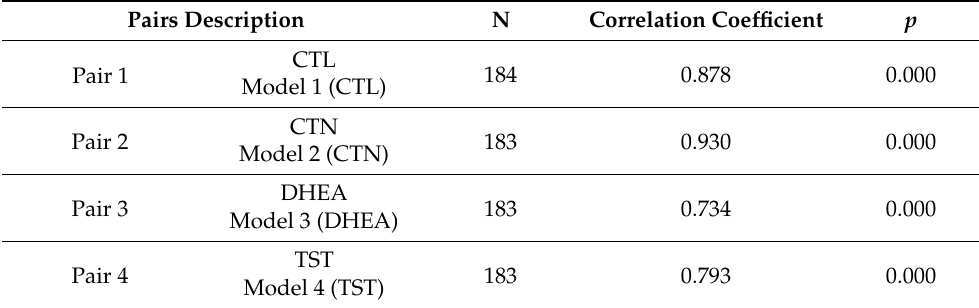
Table A2. Correlations of paired sample stress-related